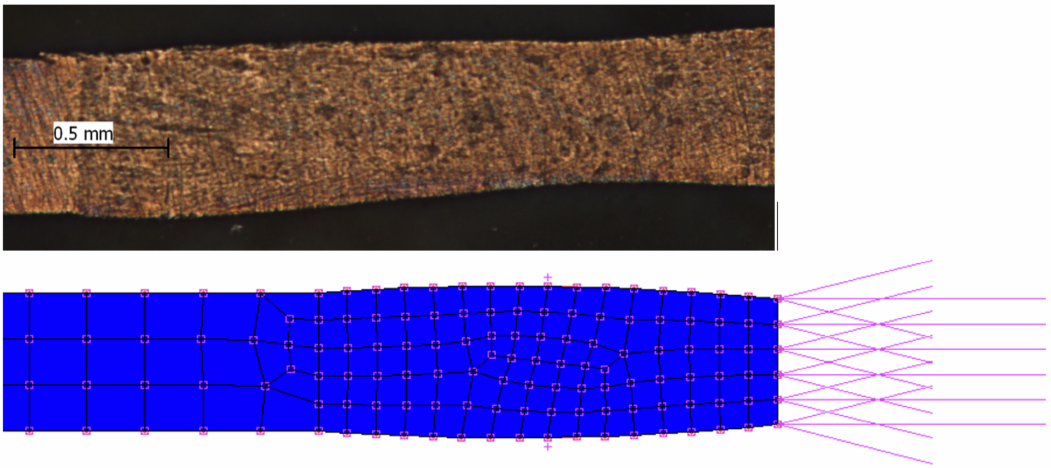
Figure 17. FEM model as per U5 specimen from Table